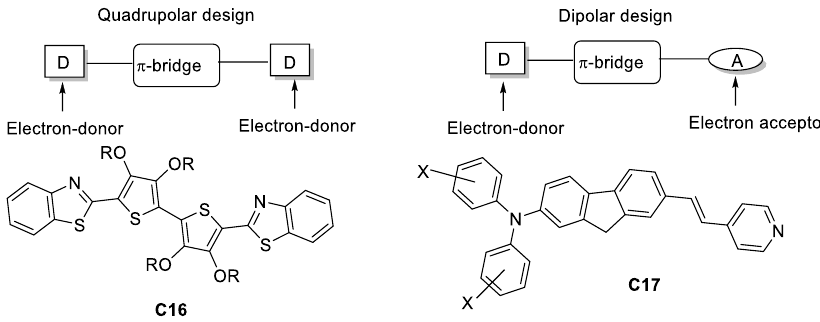
Figure 22. Examples of the most widely used molecular architectures TPA during the late 90s.